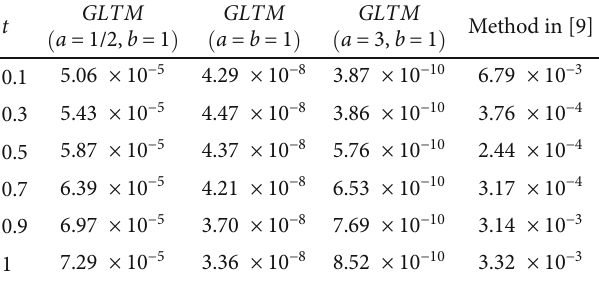
Table 4: Comparison of the MAEs of Example 7 for M = 4 .